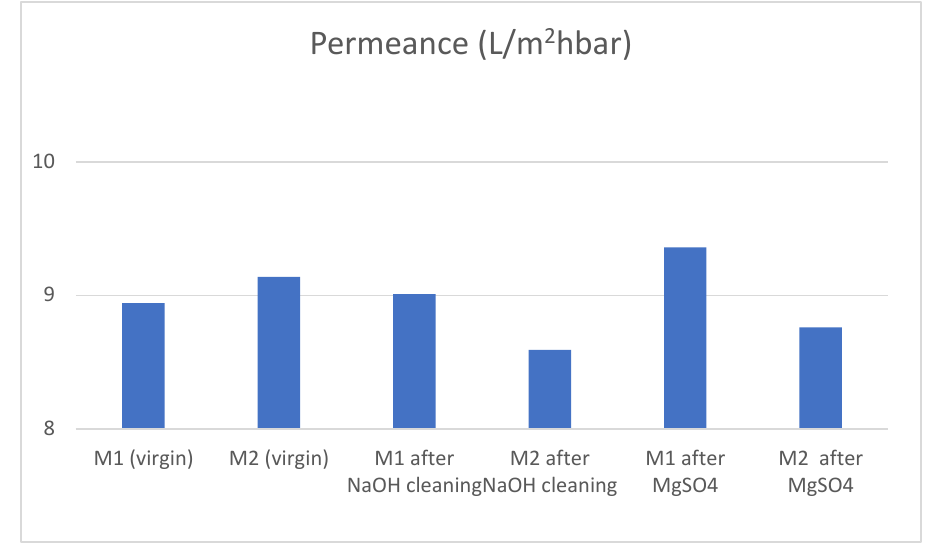
Figure 3. Permeance of virgin and cleaned membranes. Table 4. Pure salt rejections before and after